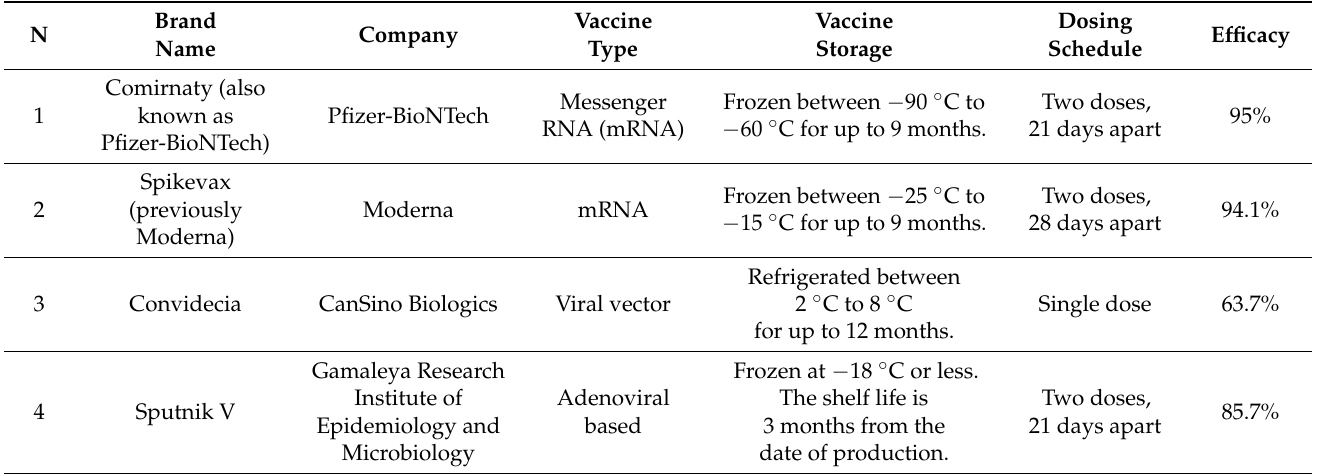
Table 1. Comparison of the most widely used COVID-19